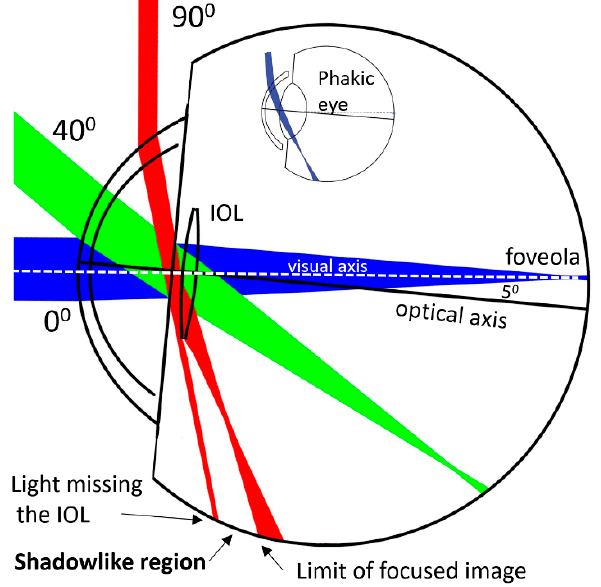
Figure 1. Raytrace plot for a pseudophakic right eye from above, with 2.5 mm actual pupil diameter. At large angles there is vignetting at the intraocular lens (IOL) and the main image goes dark. Light can also bypass the IOL and illuminate the retina directly, though that light comes from a lower visual angle than for the phakic eye.